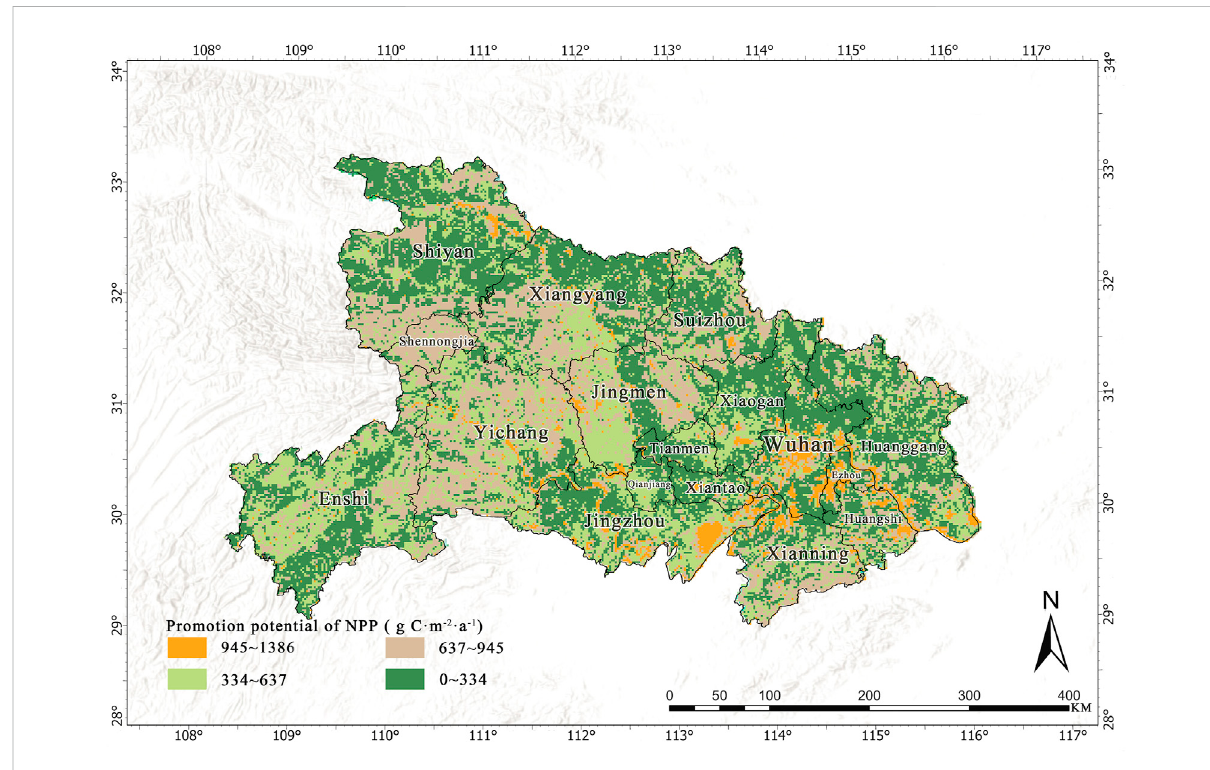
FIGURE 9 Spatial distribution of the promotion potential of NPP in Hubei